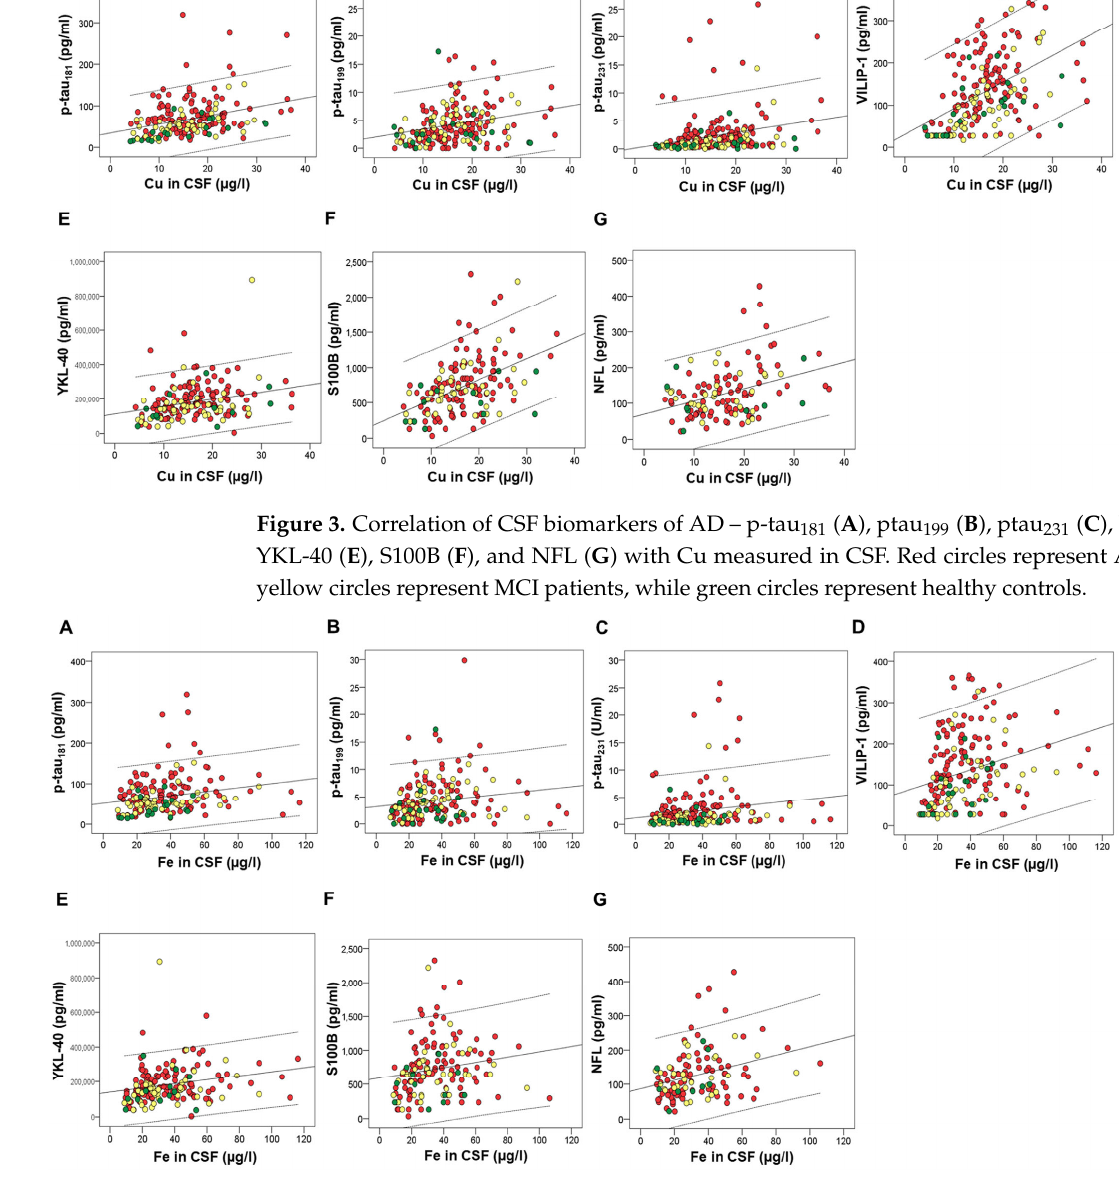
Figure 4. Correlation of CSF biomarkers of AD – p-tau 181 ( A ), ptau 199 ( B ), ptau 231 ( C ), VILIP-1 ( D ), YKL-40 ( E ), S100B ( F ), and NFL ( G ) with Fe measured in CSF. Red circles represent AD patients, yellow circles represent MCI patients, while green circles represent healthy